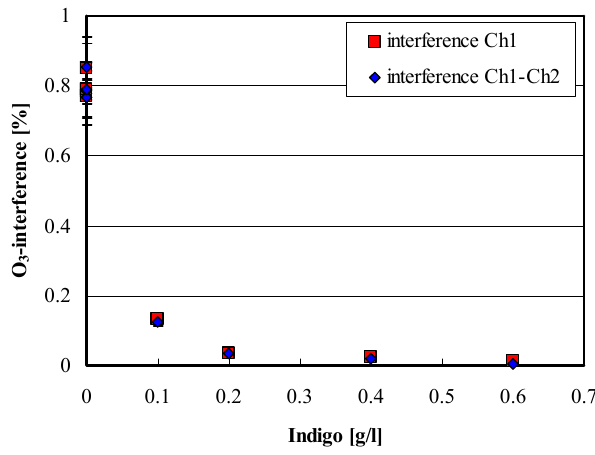
Fig. 8. O 3 interference as a function of Indigo concentration Fig. 8: O 3 interference as a function of Indigo concentration ([O 3 ] = 240 ppbv). ([O 3